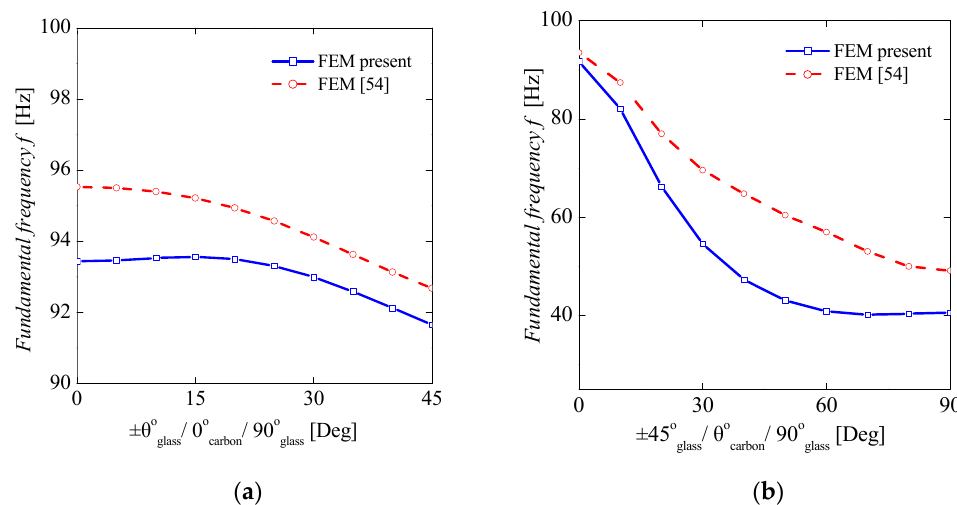
Figure 4. Fundamental frequency as a function of fiber orientation angle ( θ ◦ ). A hybrid 372 composite drive shaft having four layers stacking of ( a ) [ ± θ ◦ glass/0 ◦ carbon/90 ◦ glass] and ( b ) [ ± 45 ◦ glass/ θ ◦ carbon/90 ◦ glass] was analyzed for length = 1730 mm, radius = 50.8 mm, and wall thickness = 2.032 mm, for modal analysis, where the fiber orientation and the control parameter θ ◦ [deg] were transformed. Figures ( a , b ) show the effect of fiber orientation angle on f [Hz] by changing the first two layers and the third (carbon fiber) layer, respectively. To ensure the validity of the process, identical material properties were employed. The present approach and FEM [56] are presented by blue solid lines and dashed red lines, respectively.